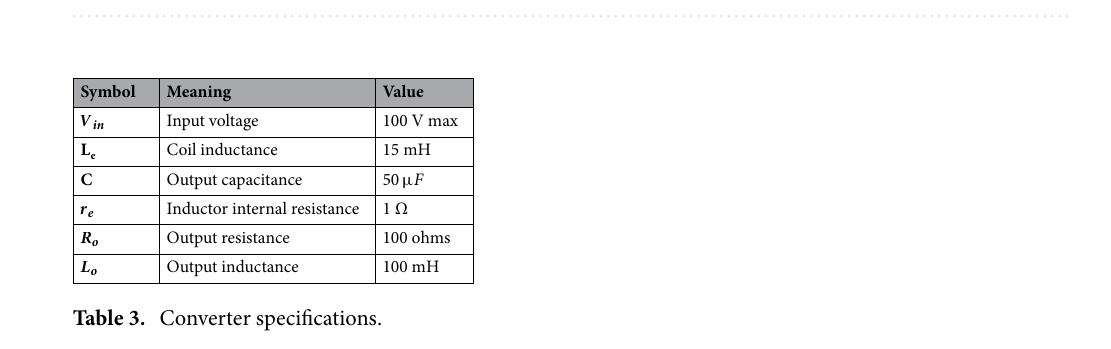
Figure 8. Response to successive changes in the reference voltage. ( a ) System response without inner loop system, ( b ) response with inner loop.